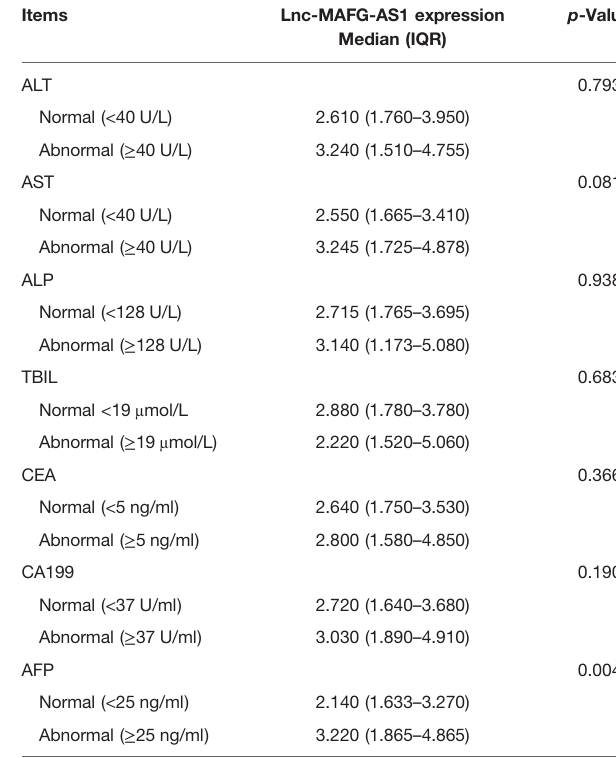
TABLE 2 | Correlation of lnc-MAFG-AS1 expression with patients ’ characteristics.